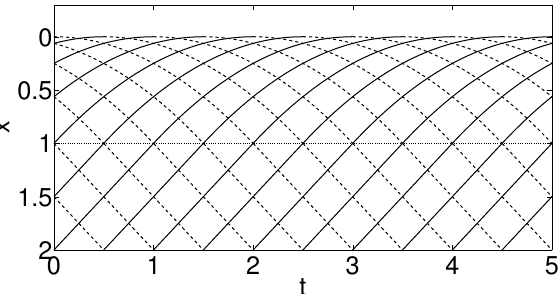
Figure 2. Plot of the characteristic curves in the case of no motion Fig. 2. Plot of the characteristic curves in case of no motion ( η = u = 0) for the dimensionless NSWE over sloping bathymetry ( η = u = 0 ) for the dimensionless NSWE over sloping bathymetry b(x) = − x for x ∈ [ 0 , 1 ] and LSWE over flat bathymetry h 0 = 1, b ( x ) = − x for x ∈ [0 , 1] and LSWE over flat bathymetry h 0 = 1 , B = 1 for x ∈ [ 1 , 2 ] . The “incoming” and “outgoing” characteristic B = 1 for x ∈ [1 , 2] . The ”incoming” and ”outgoing” characteristic curves are shown by the solid and dashed lines, respectively. The curves are shown by the solid and dashed lines, respectively. The shoreline x = 0 can be seen as the envelopes of the characteristic shoreline x = 0 can be seen as the envelope of the characteristic curves curves themselves.